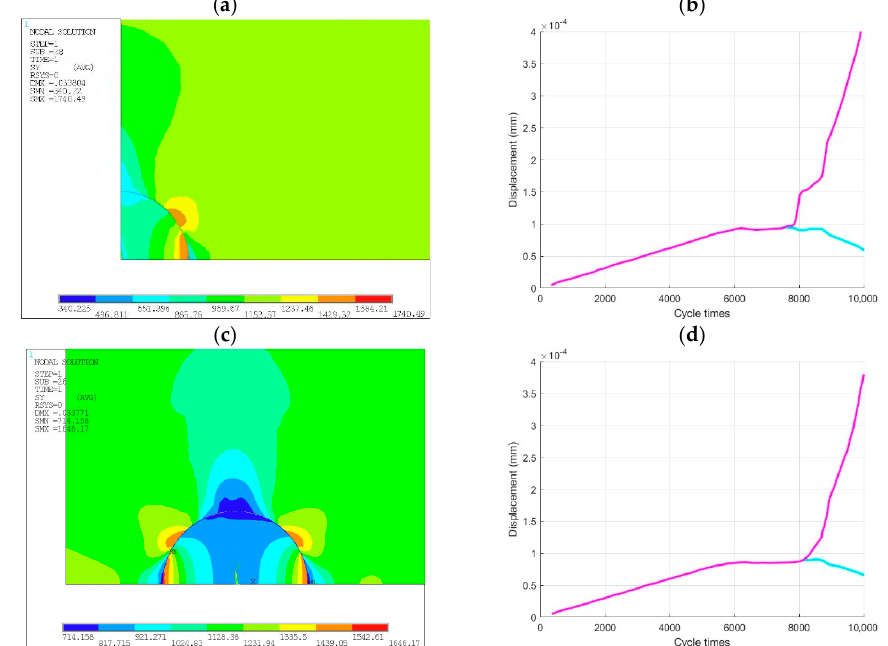
Figure 13. Effect of inclusion location on interface debonding: ( a , b ) debonding stress and contact node displacement for surface inclusion. ( c , d ) Debonding stress and contact node displacement for surface inclusion.